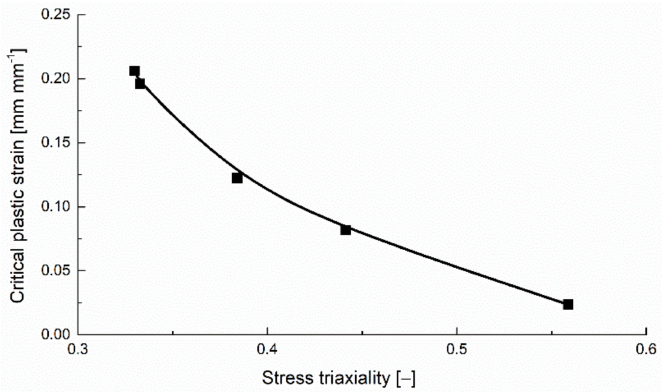
Figure 6. Critical plastic strain variation with stress triaxiality for the notched flat tensile